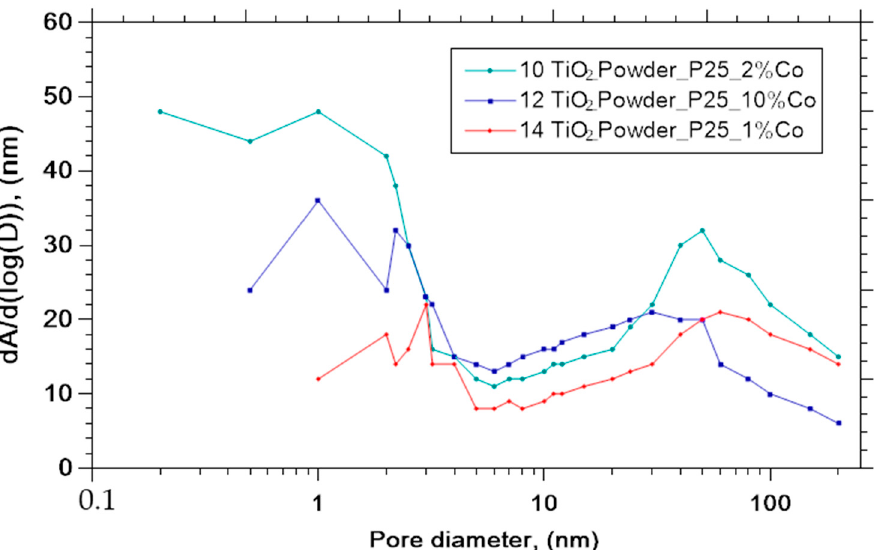
Figure 10. Pore size distribution of selected samples.